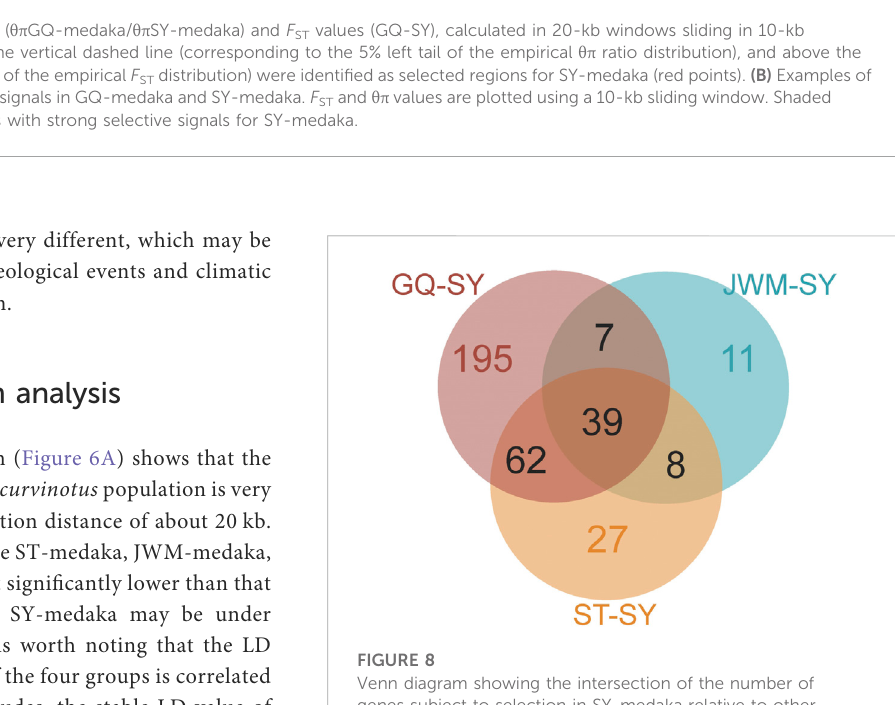
FIGURE 8 Venn diagram showing the intersection of the number of genes subject to selection in SY-medaka relative to other